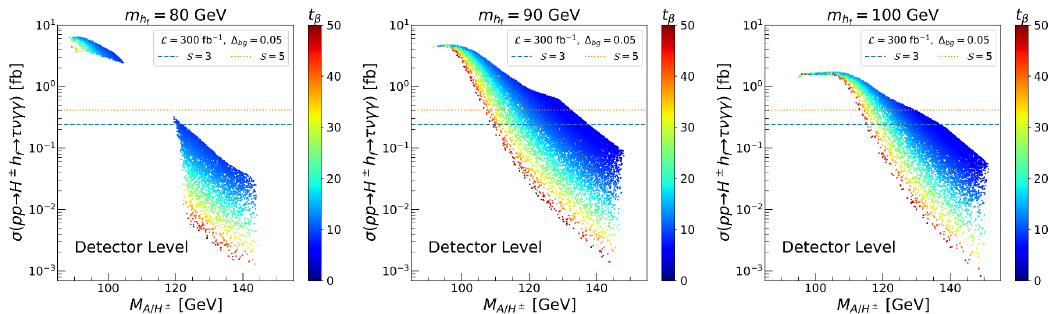
after imposing all A/H ±